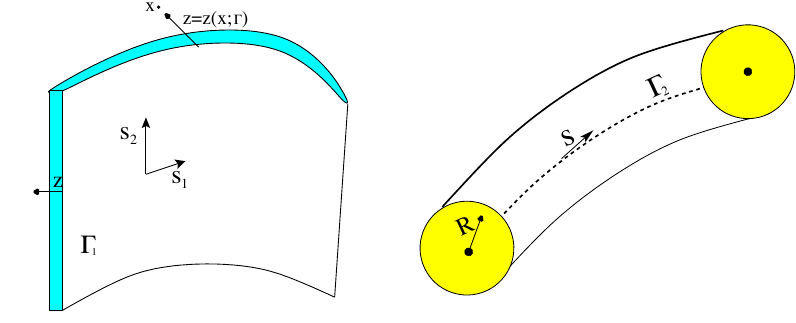
Figure 6. (Left) The co-dimension one coordinate system has a fast normal z and two , s slow directions s = ( s ; (Right) The co-dimension ) lying in the tangent plane of Γ 1 2 1 two coordinate system has a two dimensional fast sub-system parameterized by cylindrical coordinates ( R, θ ) where R is the distance from the pore center and θ is the polar angle, and a one dimensional slow system parameterized by distance s along Γ 2